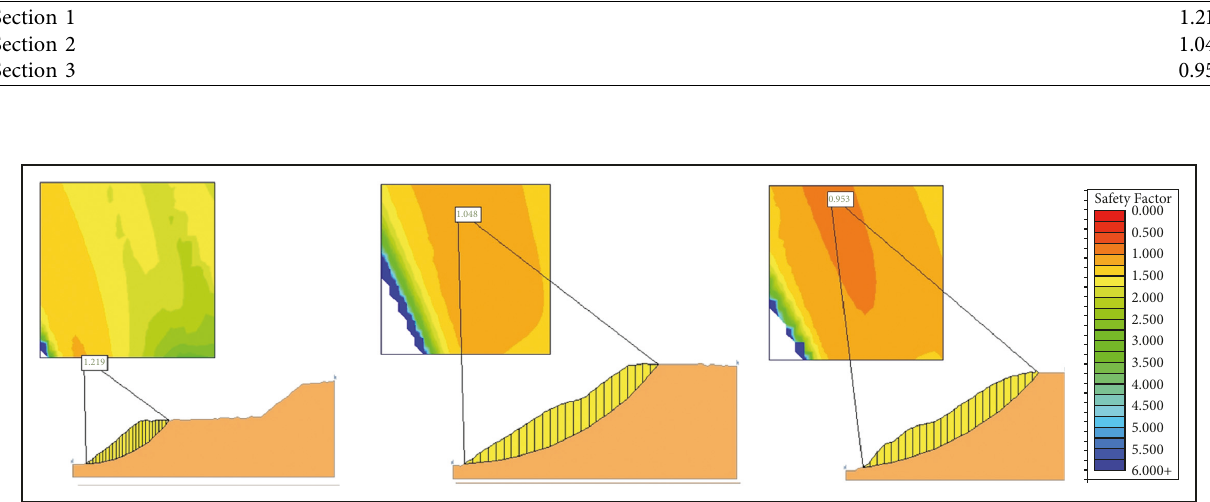
Figure 12: Pseudostatic analysis of three